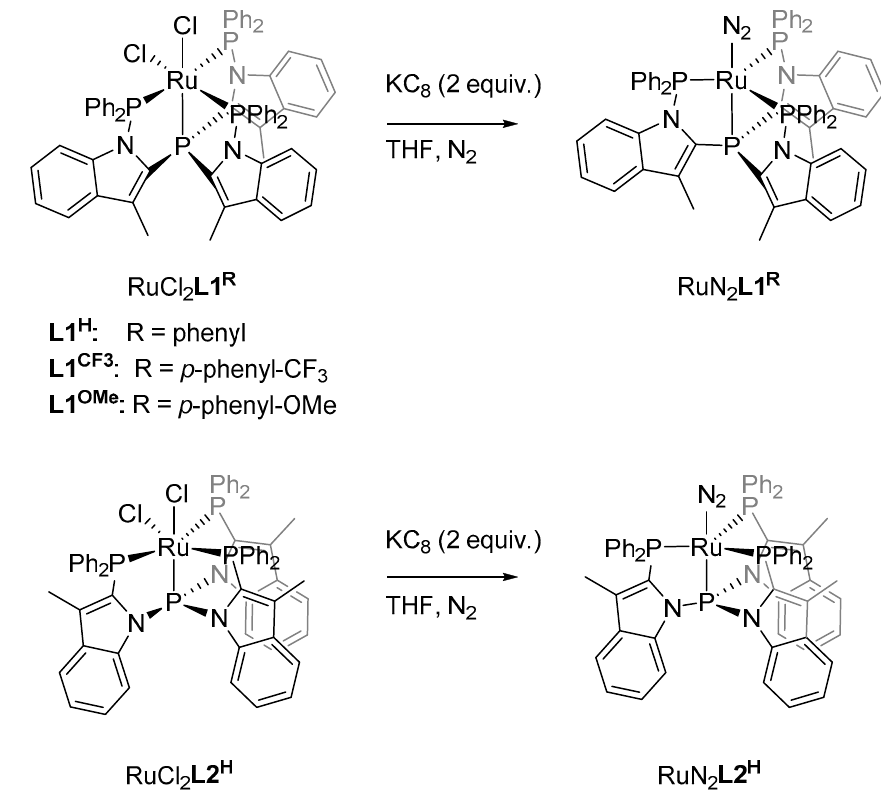
Figure 9. Reaction of RuCl 2 L complexes with two equivalents of KC 8 in presence of N 2 forming the corresponding Ru 0 (N 2 ) L . Table 2. IR frequency of the selected Ru 0 (N 2 ) L complexes.